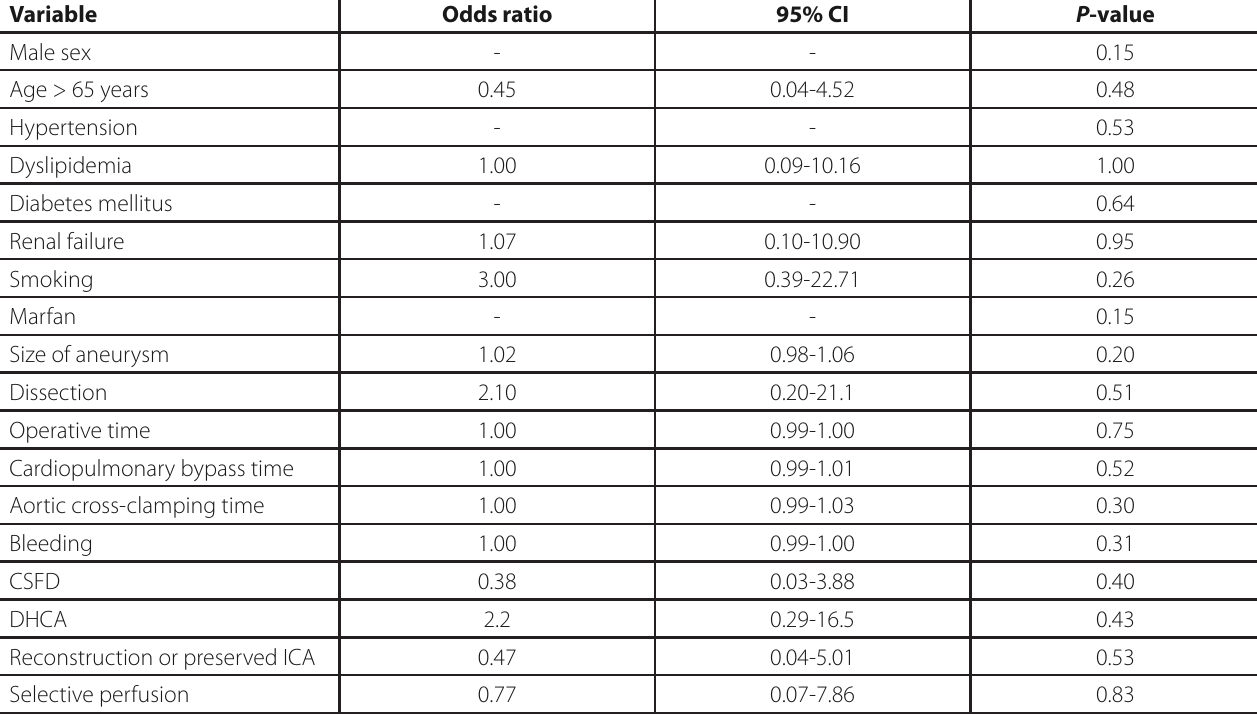
Table 3. Univariate analysis of risk factors for spinal cord injury. Variable